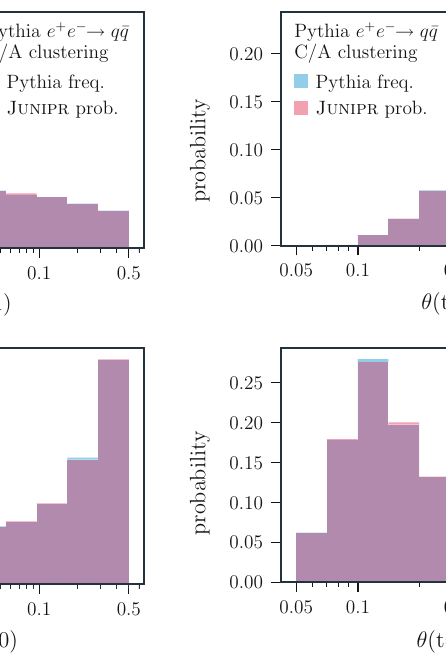
(left) and branching angle θ (right) as defined in Fig. 6. Evolution step t = 1 is shown (top) where soft wide-angle emissions are the norm, as expected in the C/A tree. Evolution step t = 10 (bottom) gives rise to harder more-collinear